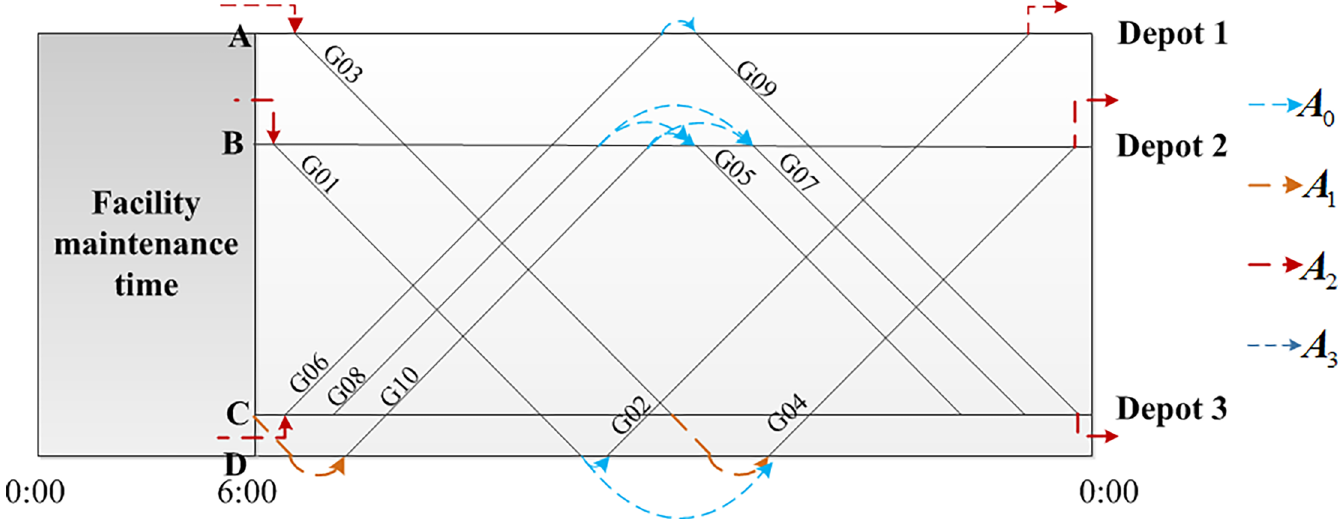
Fig 1. Connection network based on the time-space diagram of a train timetable.